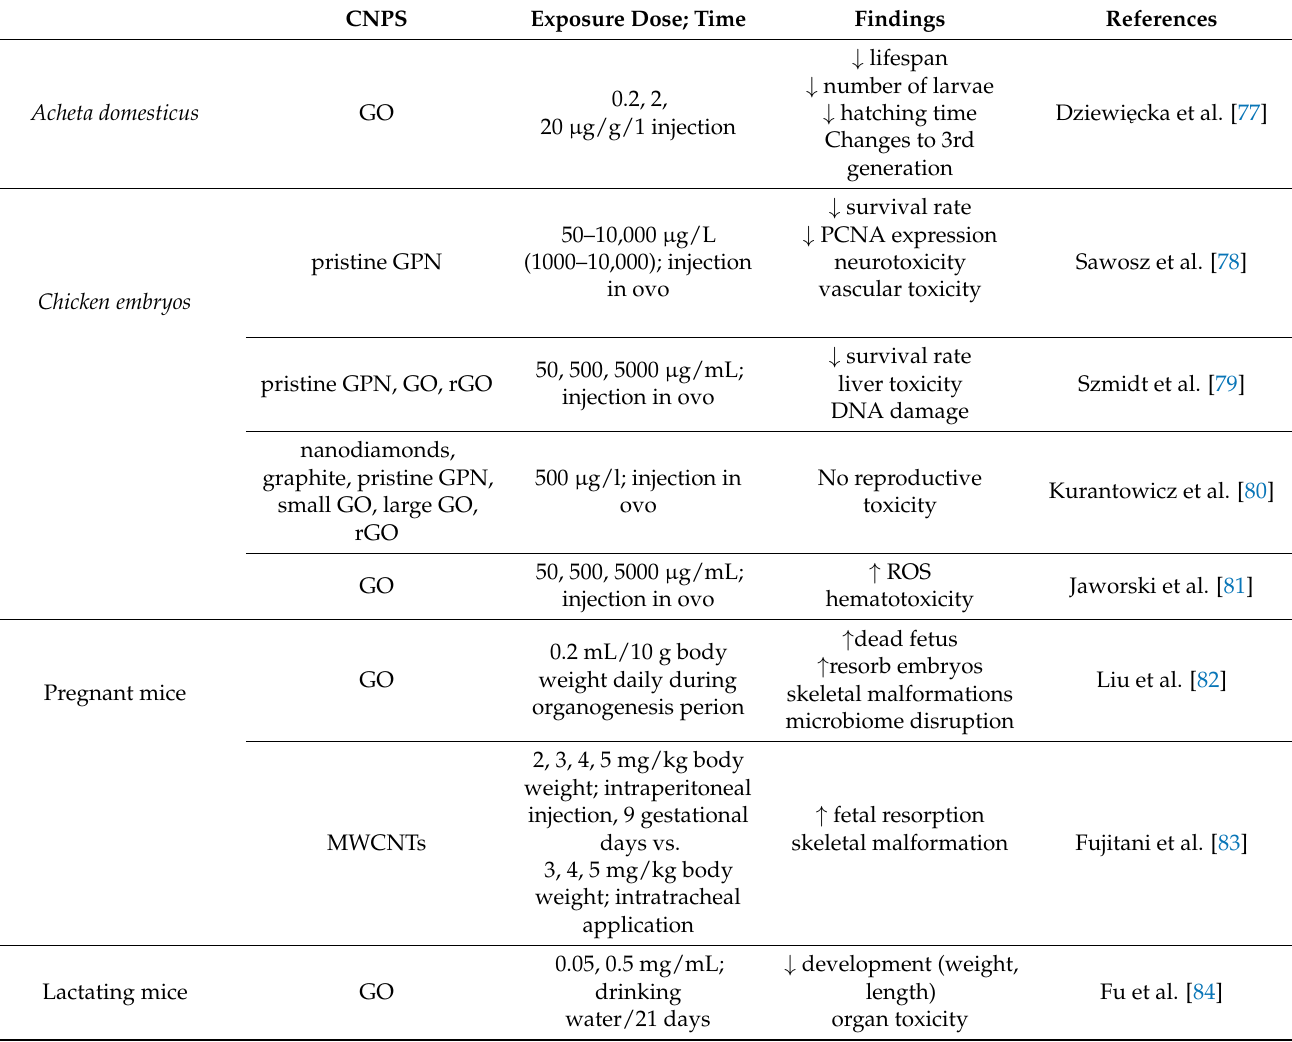
Table 2. Cont. CNPS Exposure Dose; Time